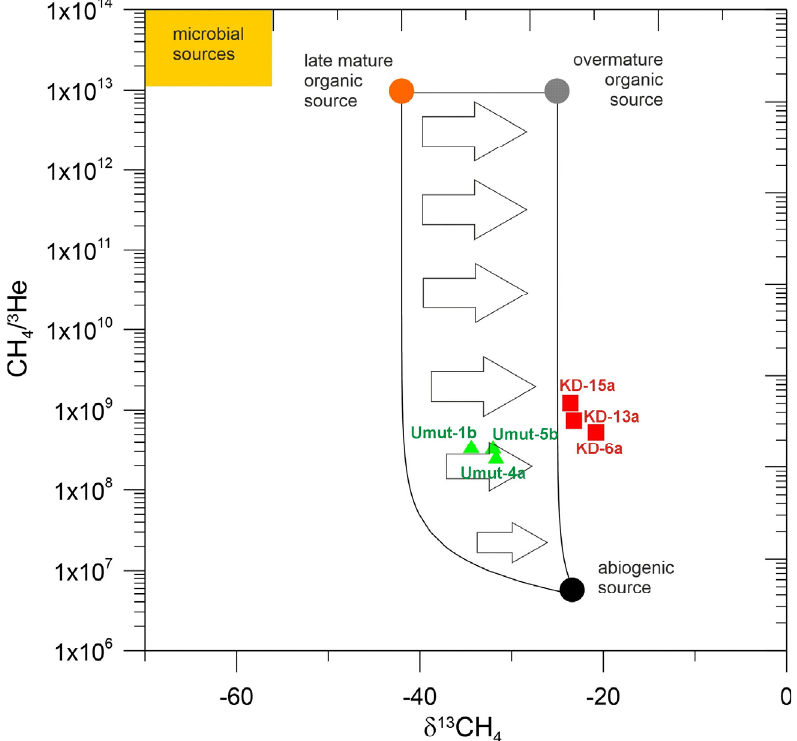
Figure 4. Correlation diagram between δ 13 C of methane and CH 4 / 3 He ratios, modified from [54]. δ 13 C values of methane from kerogen endmembers with different maturities from [68], δ 13 C values of abiogenic methane and CH 4 / 3 He ratios from [54]. Kızıldere samples: red squares. Tekke Hamam samples: green triangles. Both Tekke Hamam and Kızıldere sample show mixing between abiogenic and thermogenic methane. Tekke Hamam samples contain methane from a less mature organic source. Arrows indicate increasing thermal maturity of the source of thermogenic methane.